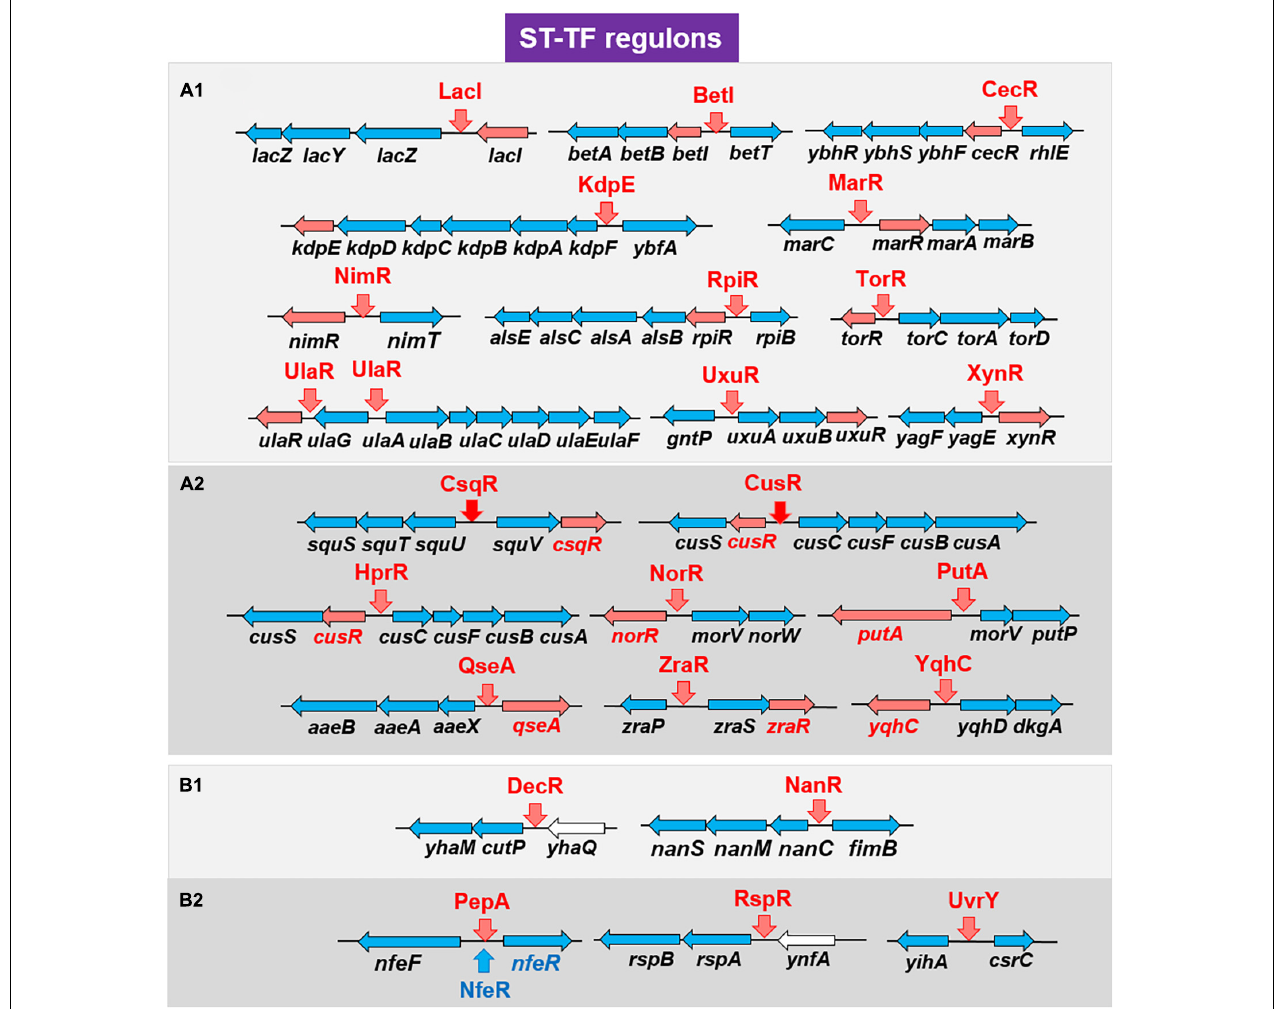
FIGURE 8 | Detailed organization of the ST-TF gene and the regulatory target gene(s). A total of 24 ST-TFs from the previous report (Shimada et al., 2018a) (A1,B1) and this report (A2,B2) were classified. (A) Type-A organization. The ST-TF proteins and their regulatory target genes are shown in red. (B) Type-B organization. The ST-TF proteins, shown in red, regulate separately located target genes. For details see